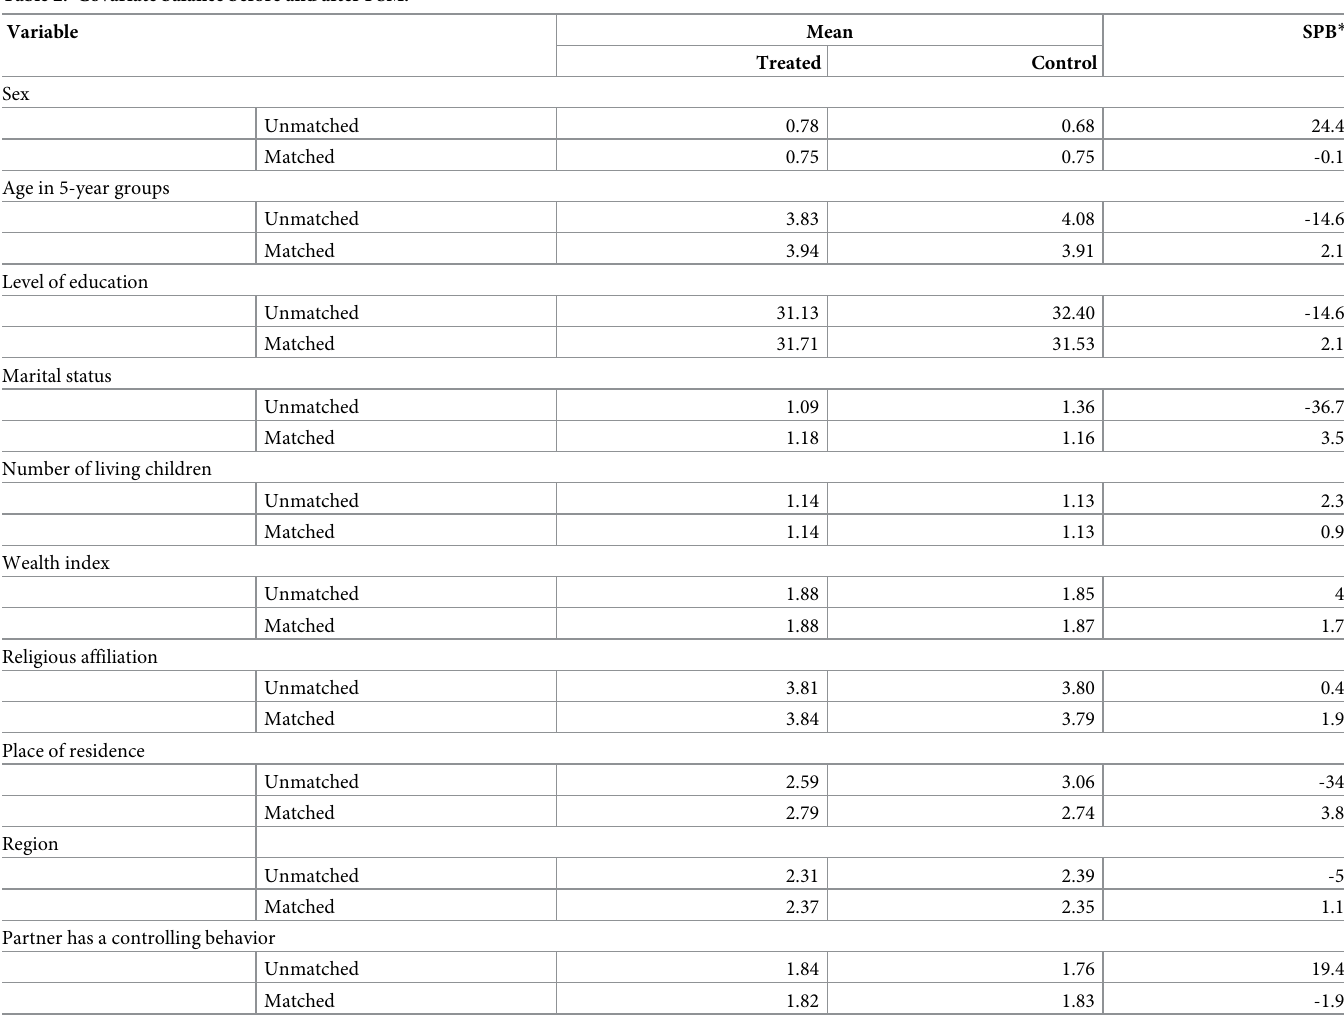
Table 2. Covariate balance before and after PSM.